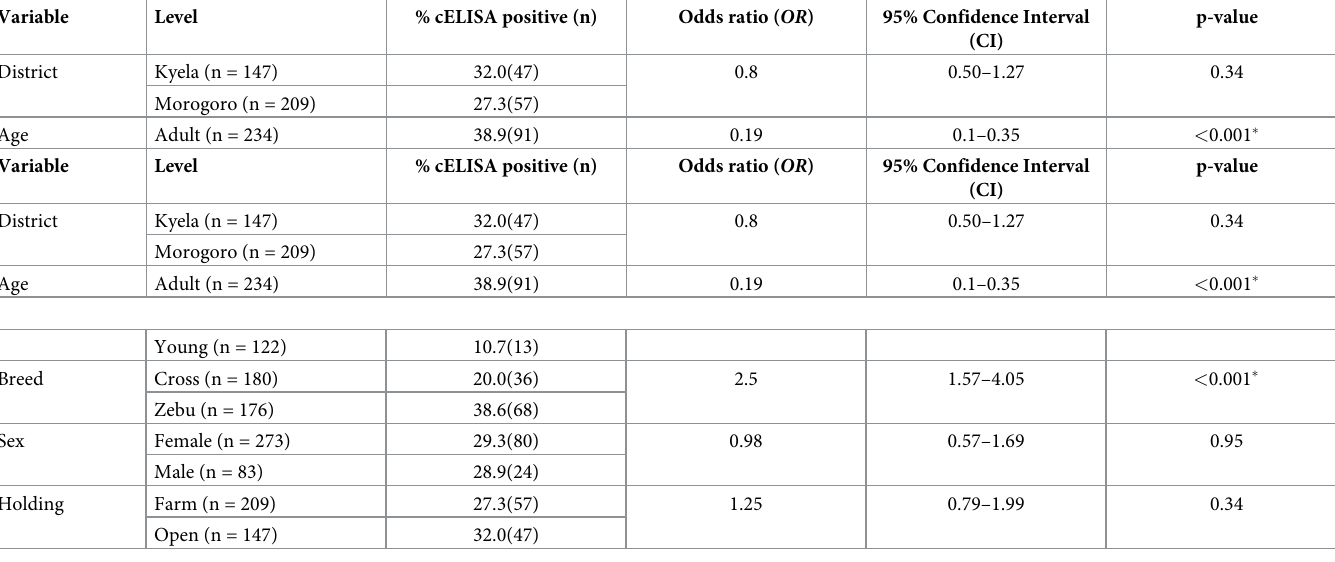
Table 1. Potential risk factors related to RVFV seroprevalence in cattle in two districts of Kyela and Morogoro, Tanzania.